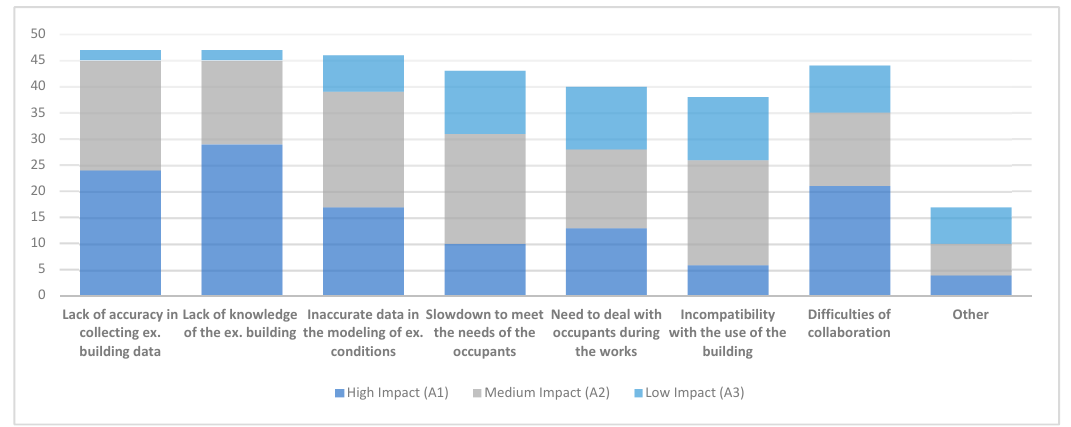
ffi ciencies of the renovation process causing time and economic Figure 3. Principal inefficiencies of the renovation process causing time and economic losses. Figure 3. Principal ine